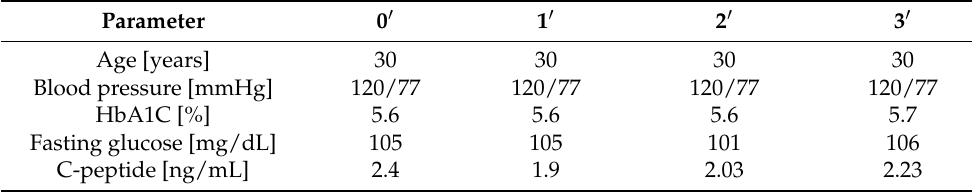
Table 4. The values of biochemical parameters before and after the MLD therapy in a patient with class 2